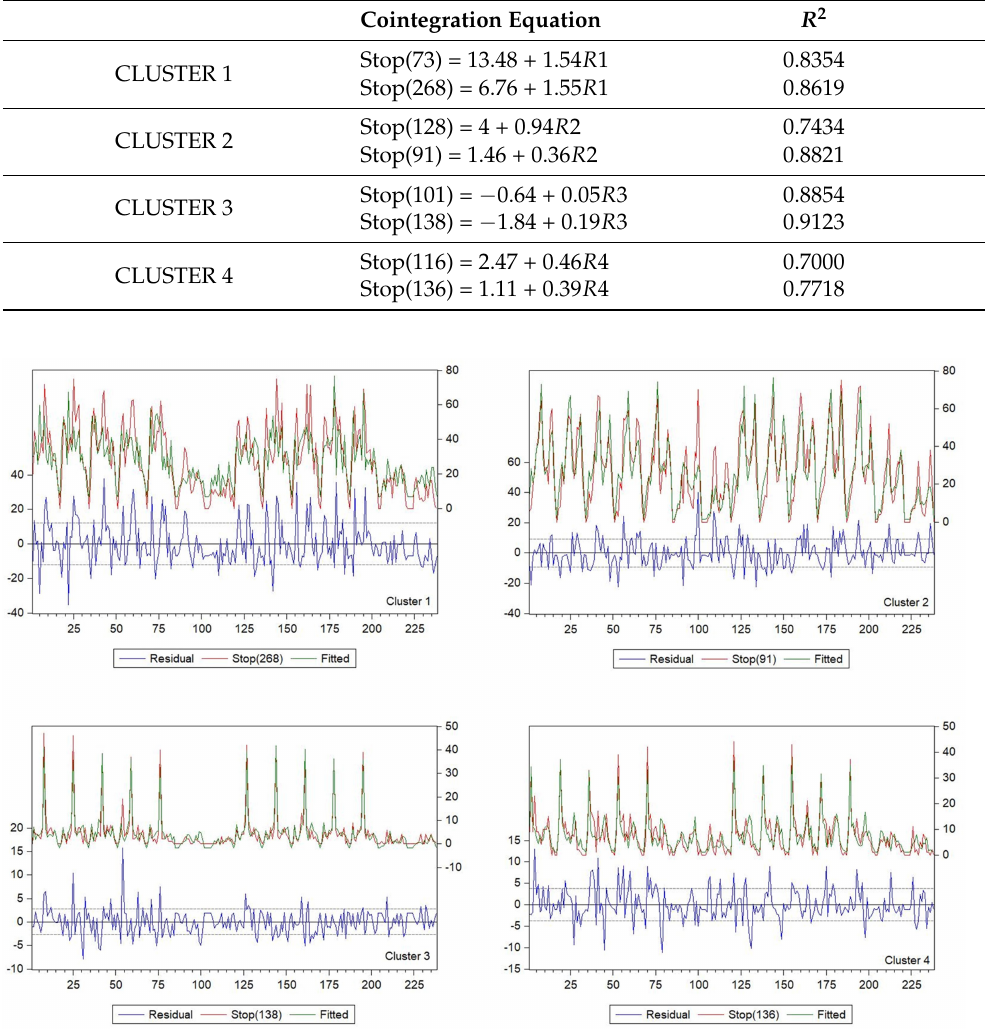
Table 6. Cointegration equations for two stops in each cluster and their representative.